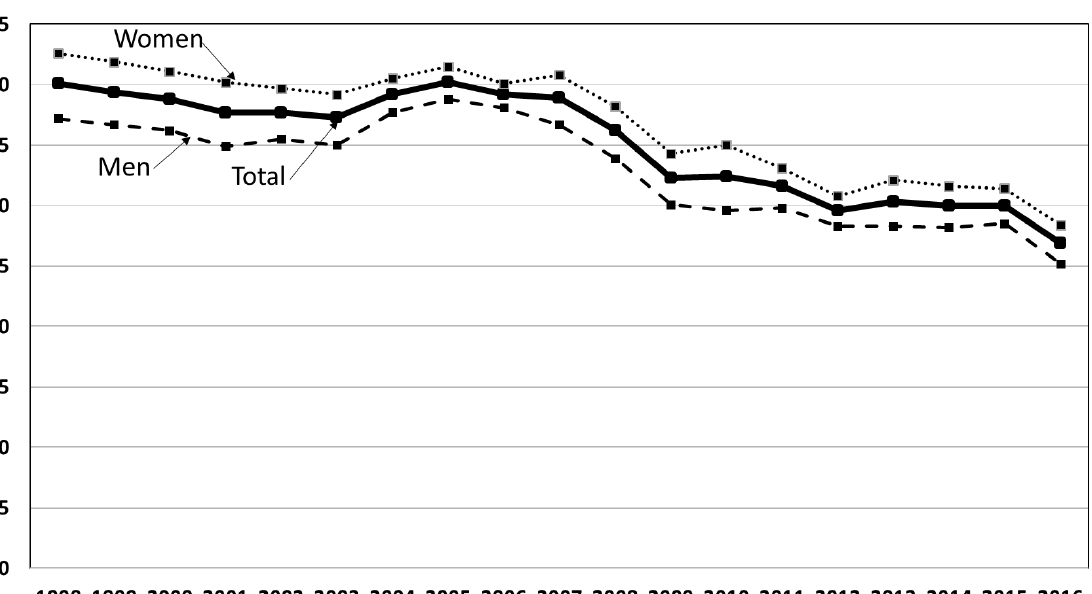
Figure C-6. Prevalence of Adults Who Engage in No Leisure-time Moderate-to-Vigorous Physical Activity, by Sex and Year, 1998 to